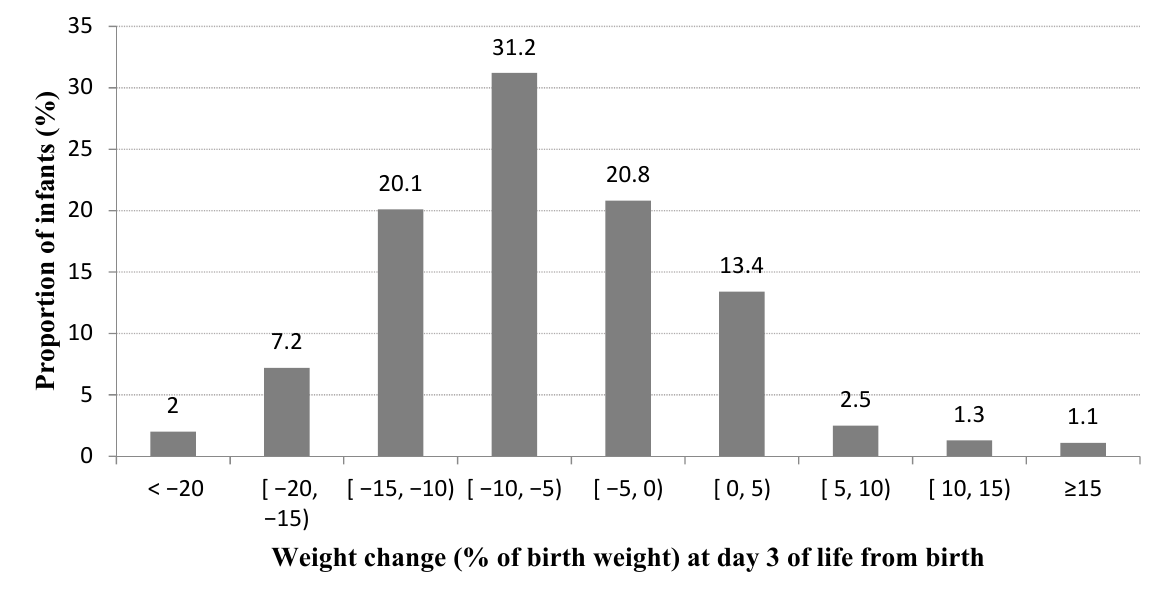
Figure 2. Distribution of weight change (expressed as % of birth weight) by day three of age.